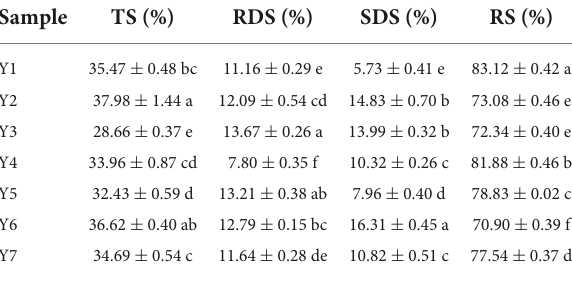
TABLE 2 Starch components of kidney